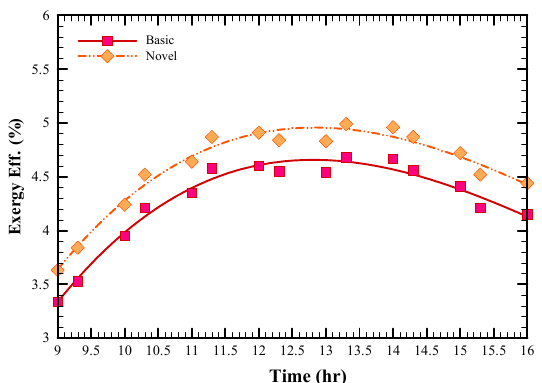
Time Figure 11. Variation of exergy efficiency for a basic system without a turbulator and novel PTSC Figure 11. Variation of exergy e ffi ciency for a basic system without a turbulator and novel PTSC equipped with a turbulator and filled with nanofluid at ϕ = 0.019% and Re = 5000 versus different equipped with a turbulator and filled with nanofluid at φ = 0.019% and Re = 5000 versus di ff erent times of day. times of